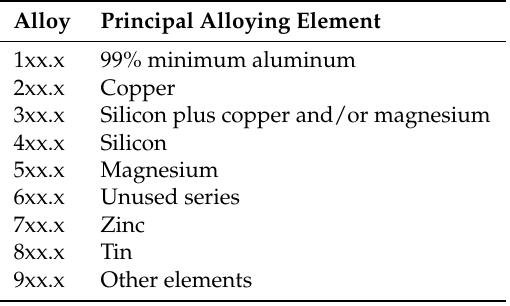
Table A2. Principal alloying element for cast aluminum